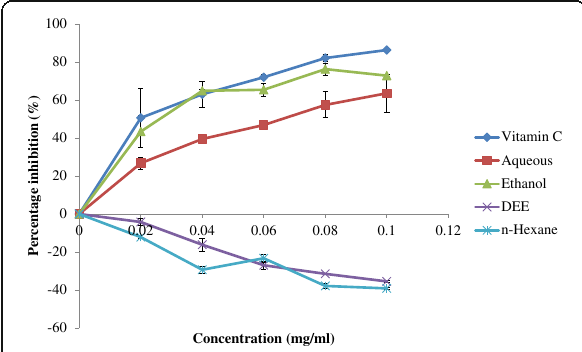
Fig. 1 DPPH radical scavenging activities of n-hexane, diethyl ether, ethanol and aqueous extracts of Feretia apodanthera Discussion